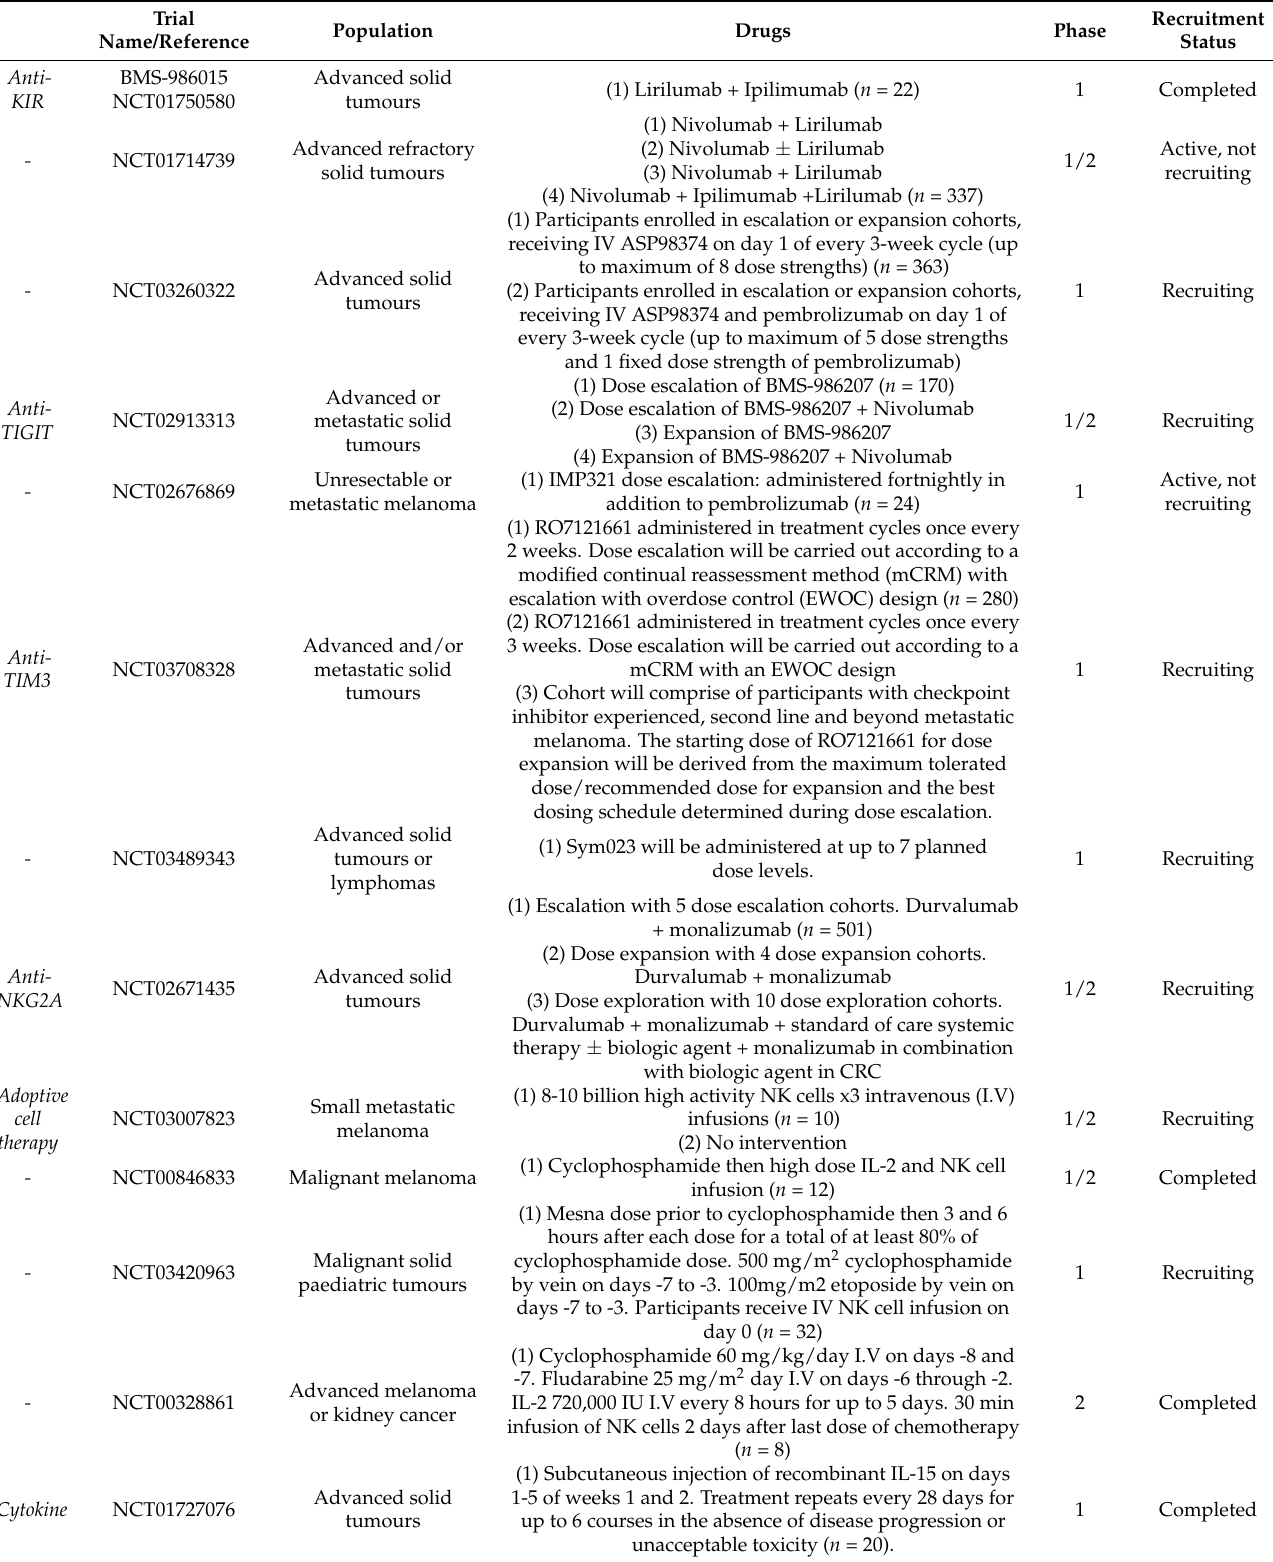
Table 1. Table of clinical trials involving drugs that optimize NK cell